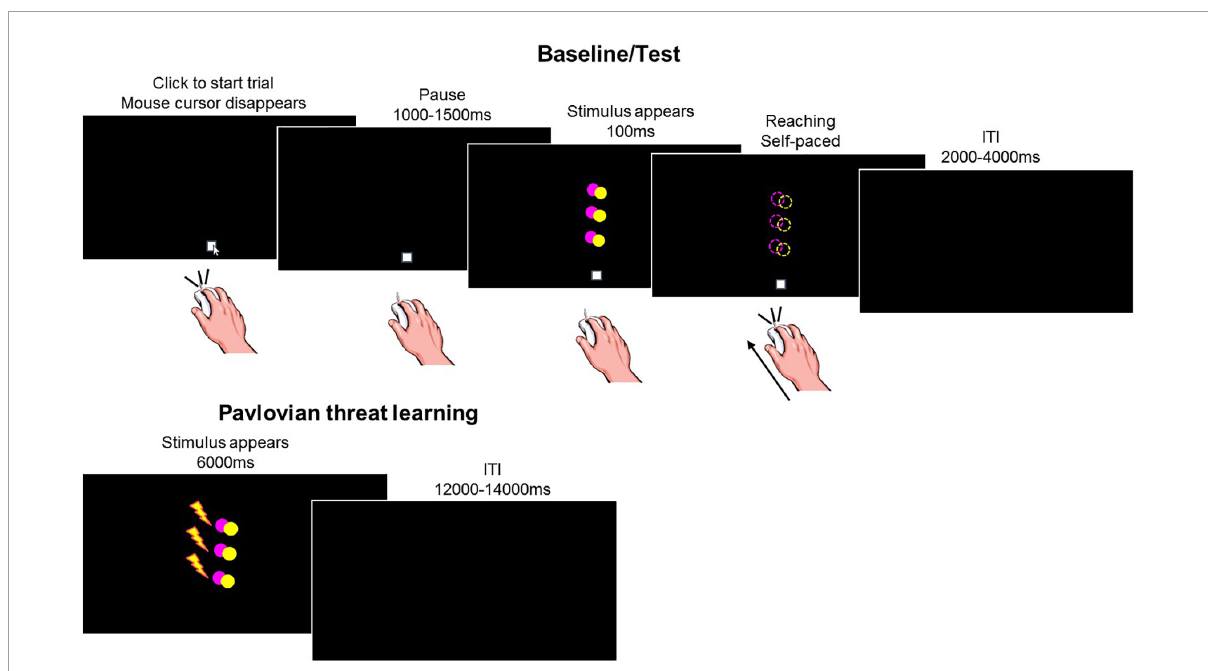
FIGURE1 Experimental task. During baseline and test, participants made reaching movements with the computer mouse toward the stimuli appearing on the screen. The task included two colored circles (yellow or pink). On each trial, one of the circles appeared in one out of three positions (low, middle, and high) for 100 ms. We show an example of a stimulus in the low, middle and high positions, represented together on the same screen for illustrative purposes only. During Pavlovian threat learning, participants learned to associate a specific stimulus color with an aversive outcome (i.e., shock, represented by the lightning), while the other color served as within-subject control condition. The task included two colored circles (yellow or pink). On each trial, one of the circles appeared in one out of three positions (low, middle, and high). We show an example of a stimulus in the low, middle, and high positions, represented together on the same screen for illustrative purposes only. Dashed circles and the lightning are for illustrative purposes only, they were not present during the actual